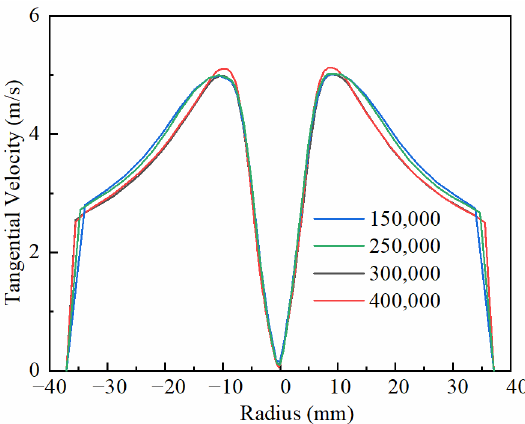
Figure 4. Verification of grid independence.